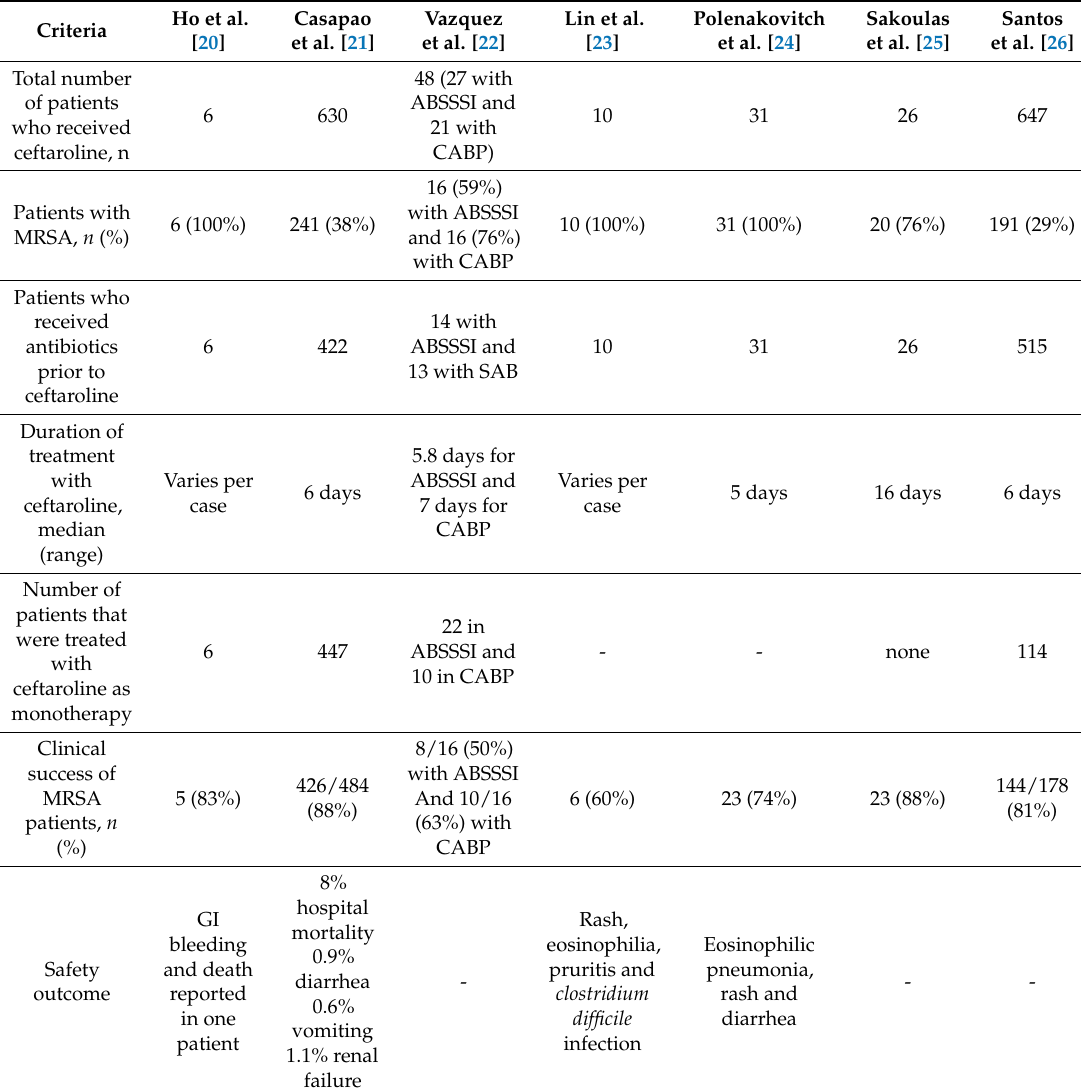
Table 3. Summary of trials for the use of ceftaroline in adult patients with MRSA infection. (ABSSSI = Acute bacterial skin and skin structure infection; CABP = community-acquired bacterial pneumonia; SAB = Staphylococcus aureus